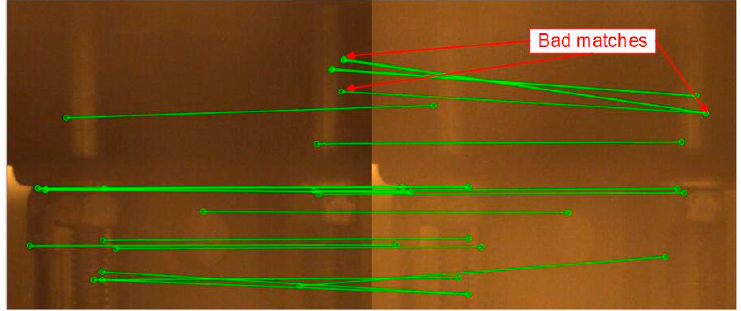
Figure 18. Poor matches when using feature-based methods (fog interference).